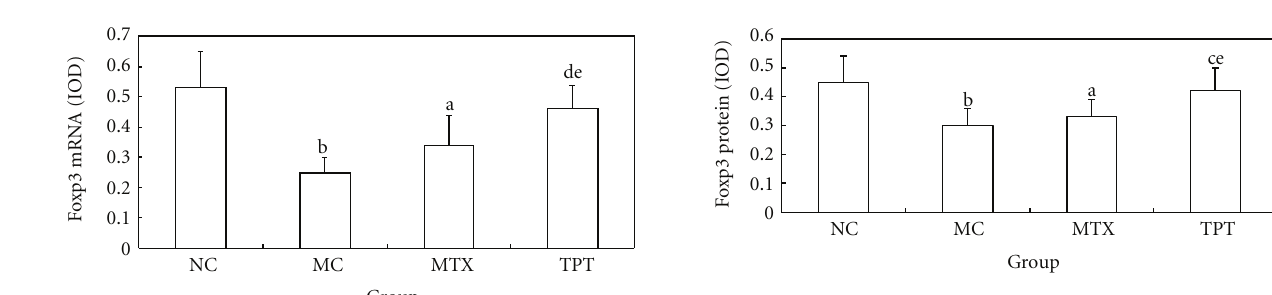
Figure 4: Comparisons of Foxp3 protein expression in each